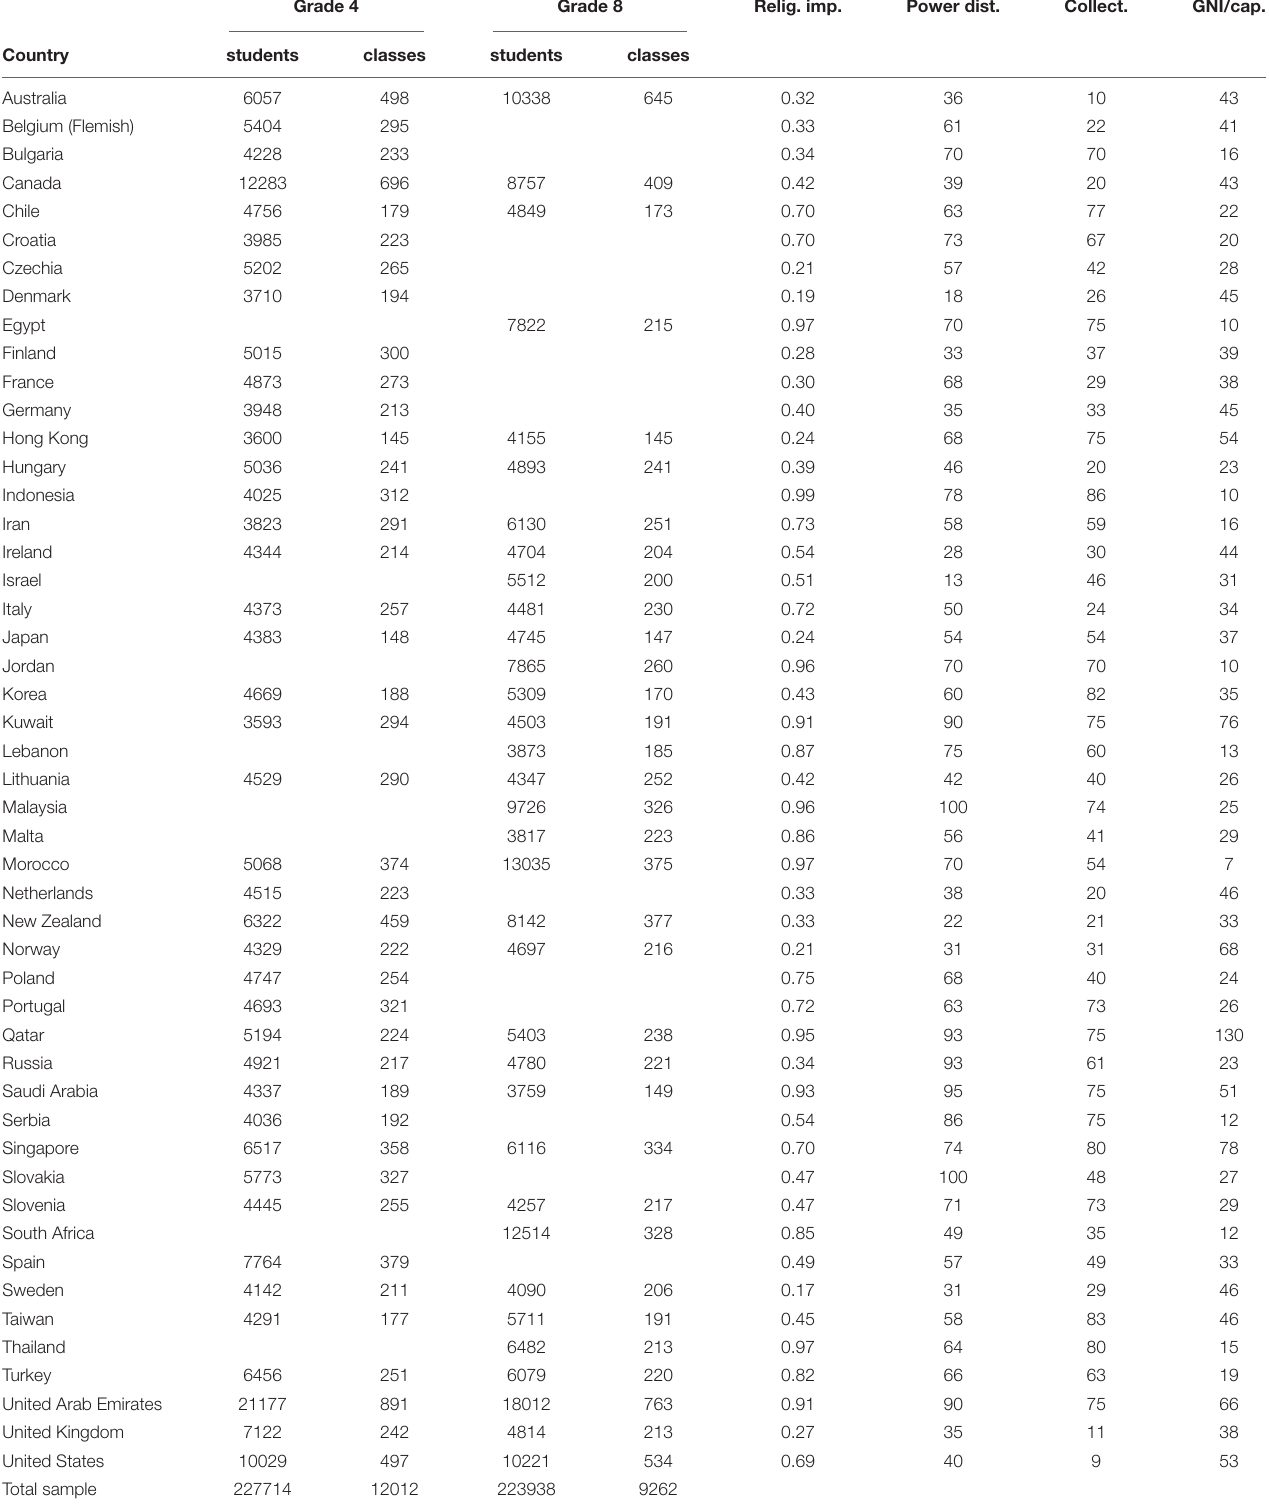
TABLE 1 | TIMSS Sample Sizes and Country Measures from Other Sources than